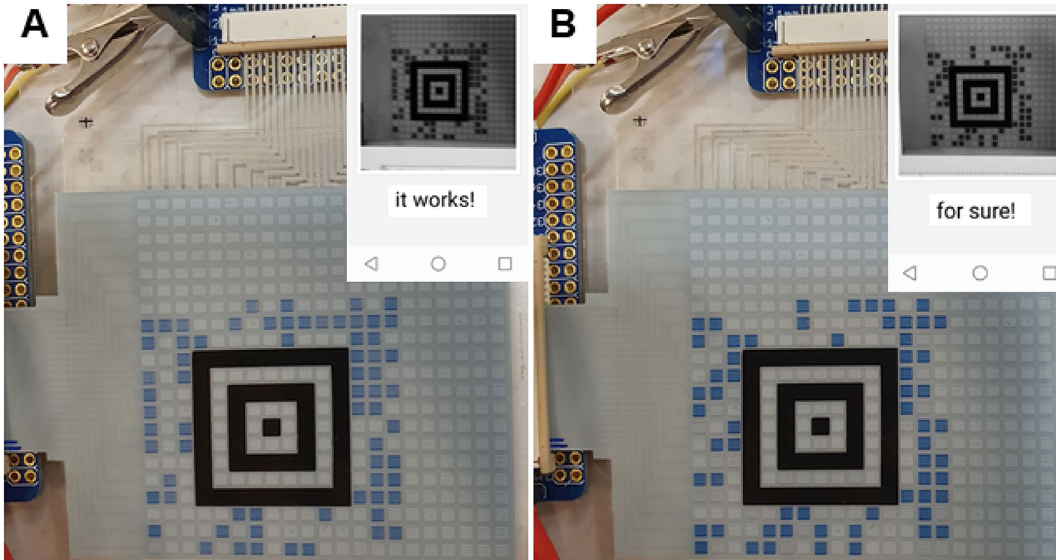
Figure 3. The concept of dynamic QR codes allows for novel IoT applications, e.g. , within authentication. Two different QR codes are subsequently presented in the same PMAD device, resulting in two unique messages upon scanning the images with a mobile phone; ( A ) it works! and ( B ) for sure! . The insets are screenshots stored by the mobile phone, showing both the recorded QR code images and the interpreted